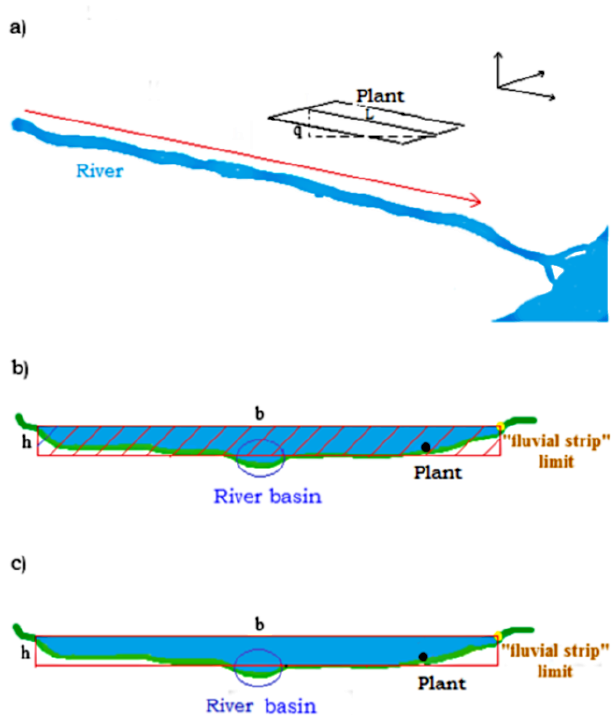
Fig. 5. Graphic representation for the estimation of the (a) slope of the channel ( s ), (b) cross section of the channel ( A ) and (c) wetted perimeter ( p ).